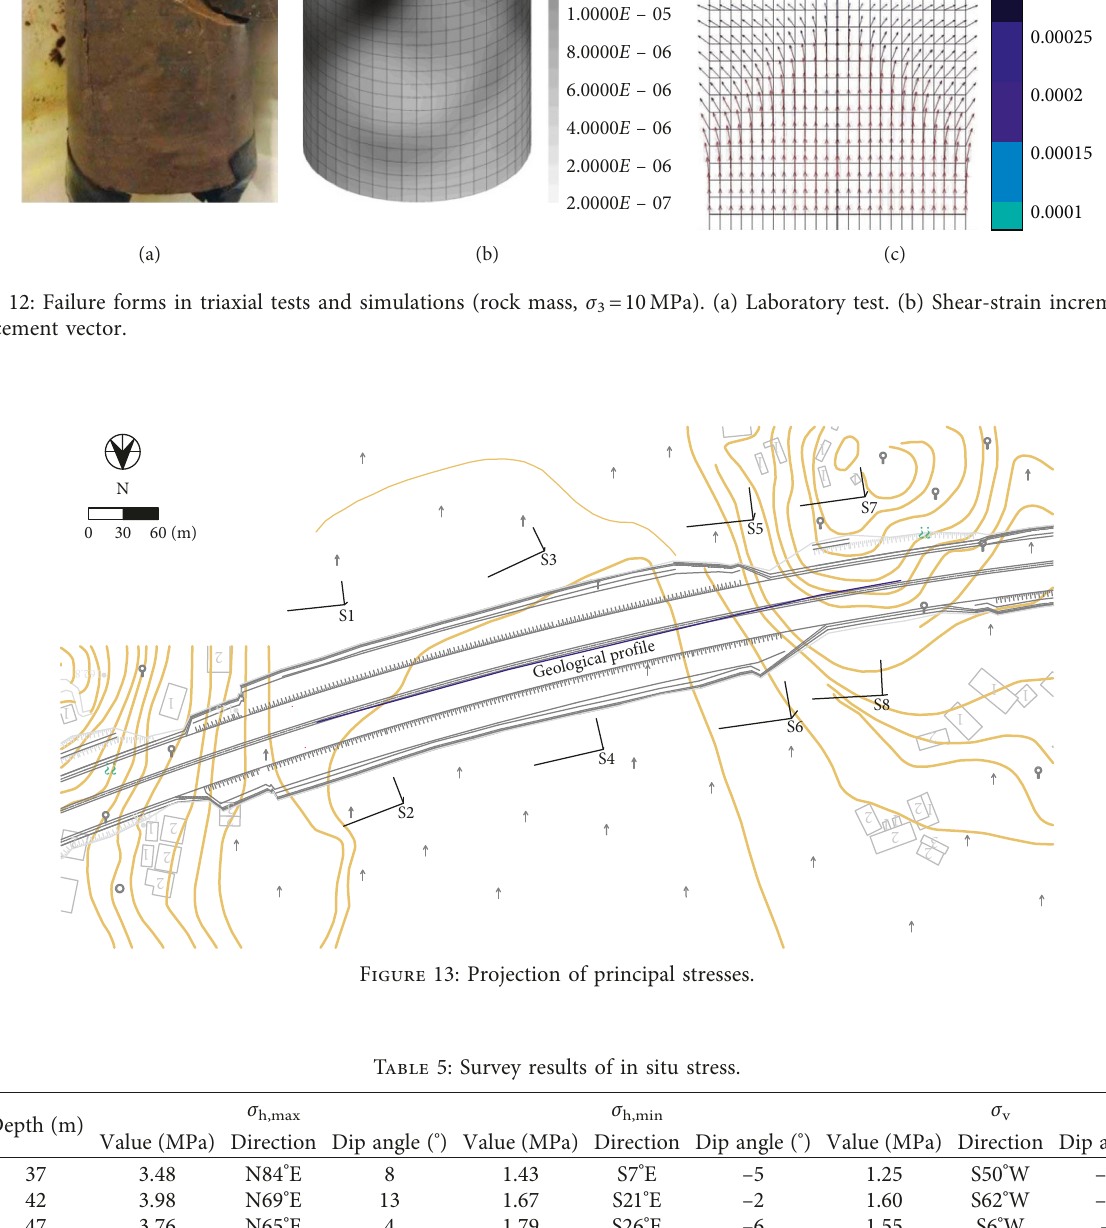
3 (cid:31) 10MPa). (a) Laboratory test. (b) Shear-strain increment. (c)